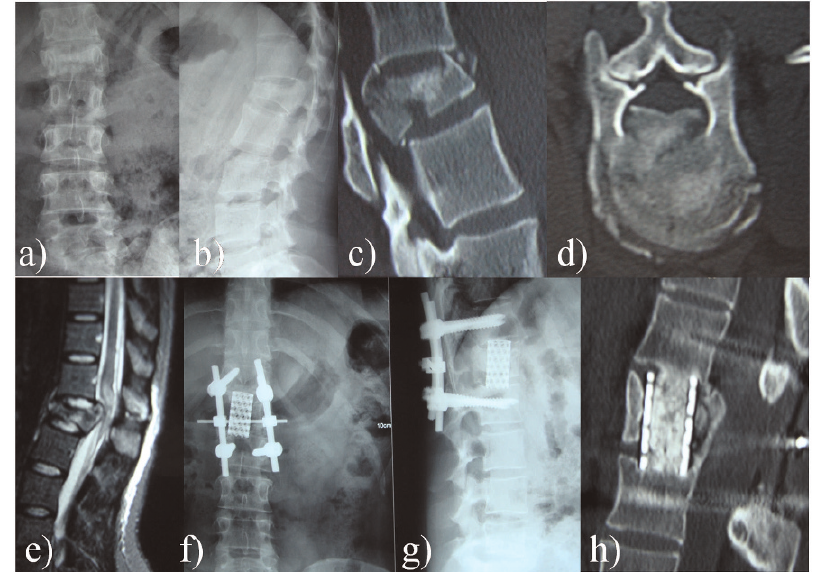
Figure 2 - Typical case two: a) and b) the preoperative X-ray shows the L1 fractures; c) and d) preoperative CT scan of the L1 vertebral body; e) the preoperative MRI examination shows spinal cord compression; f) and g) the postoperative X-ray of the L1 body shows that the fracture achieved good reduction; h) postoperative CT scan of the L1 vertebral